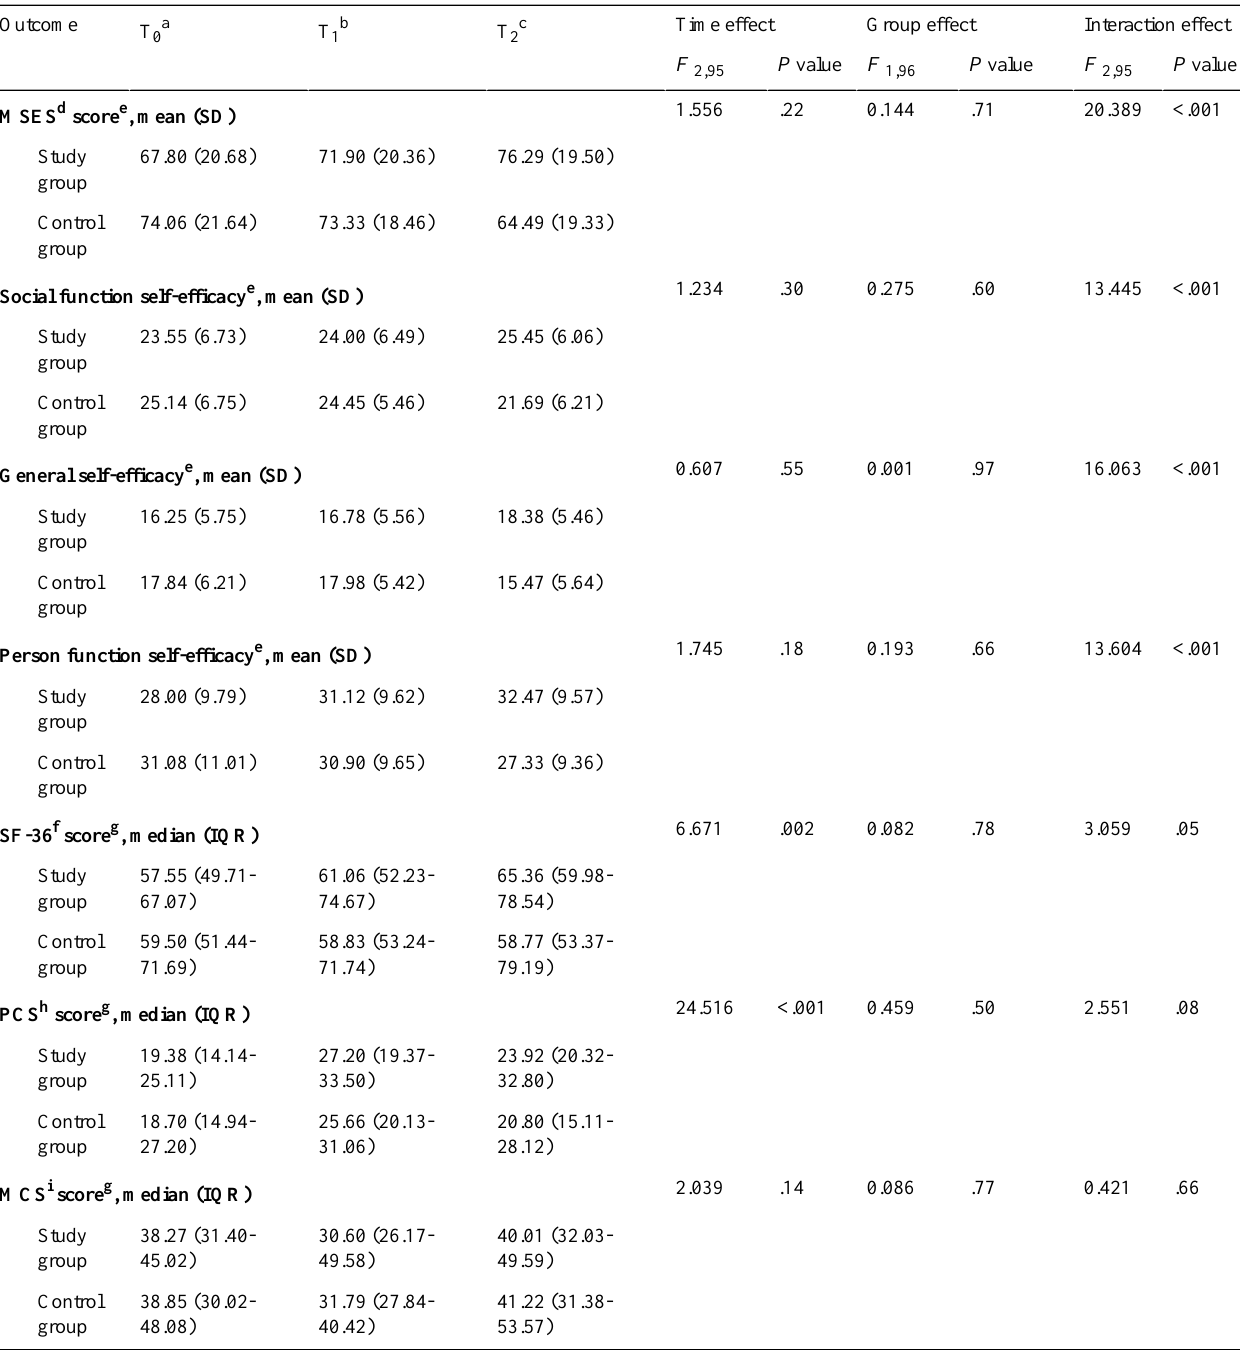
Table 4. Repeated measures analysis of variance for the Moorong Self-Efficacy Scale and the 36-item Short-Form Health Survey between the study group (n=49) and control group